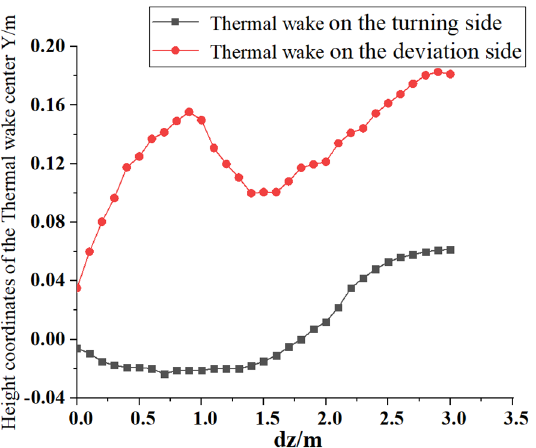
Figure 15. Variation of center height of thermal wake with distance DZ away from the rear of the body.